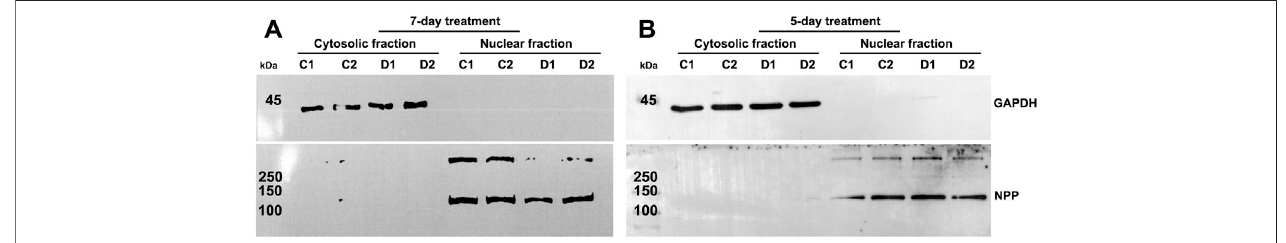
FIGURE 1 | Con fi rmation of purity of nuclear protein fractions isolated from human trabecular meshwork (TM) cells. (A,B) depict immunoblotting results for glyceraldehyde 3-phosphate dehydrogenase (GAPDH) and nuclear pore protein (NPP) in cytosolic and nuclear protein fractions, respectively, isolated from human TM cellstreatedwithdexamethasone(Dex)foraperiodof5-or7-days.ThenuclearproteinfractionsshowstrongstainingforNPPbutnoimmunopositivebandsforGAPDH, con fi rming the purity of the nuclear extracts. C1 and C2 and D1 and D2 represent control replicates 1 and 2, and Dex treated replicates 1 and 2, respectively. The nuclear protein fractions from 5- and 7-day Dex treated TM cells were isolated using the commercial kit and in house procedures, respectively, as described in the Methods